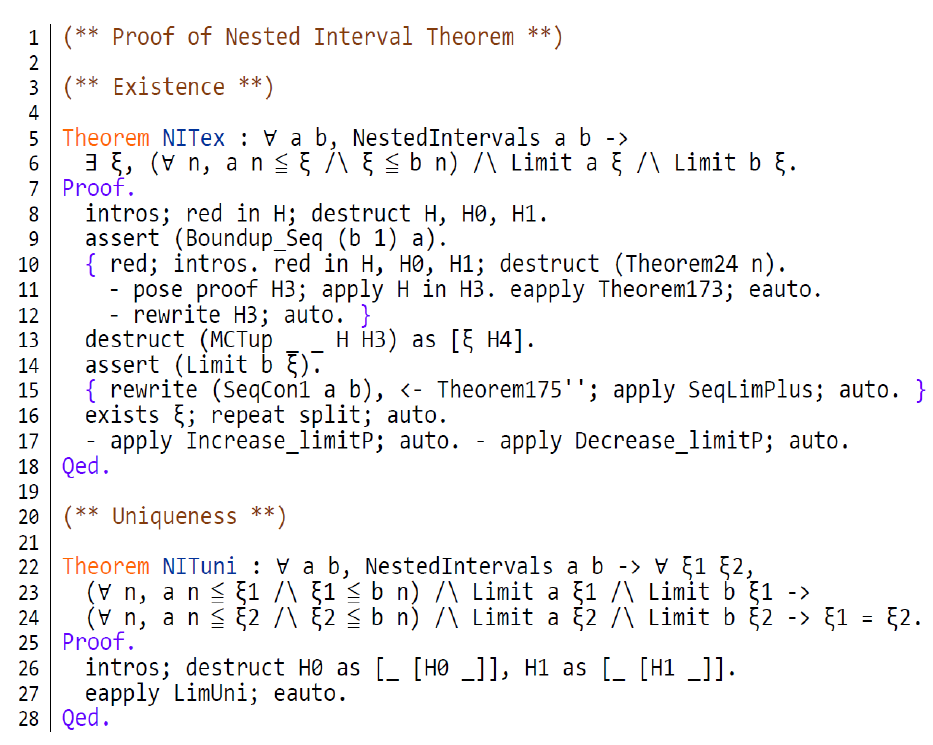
Figure 2. The proof code of the Nested interval